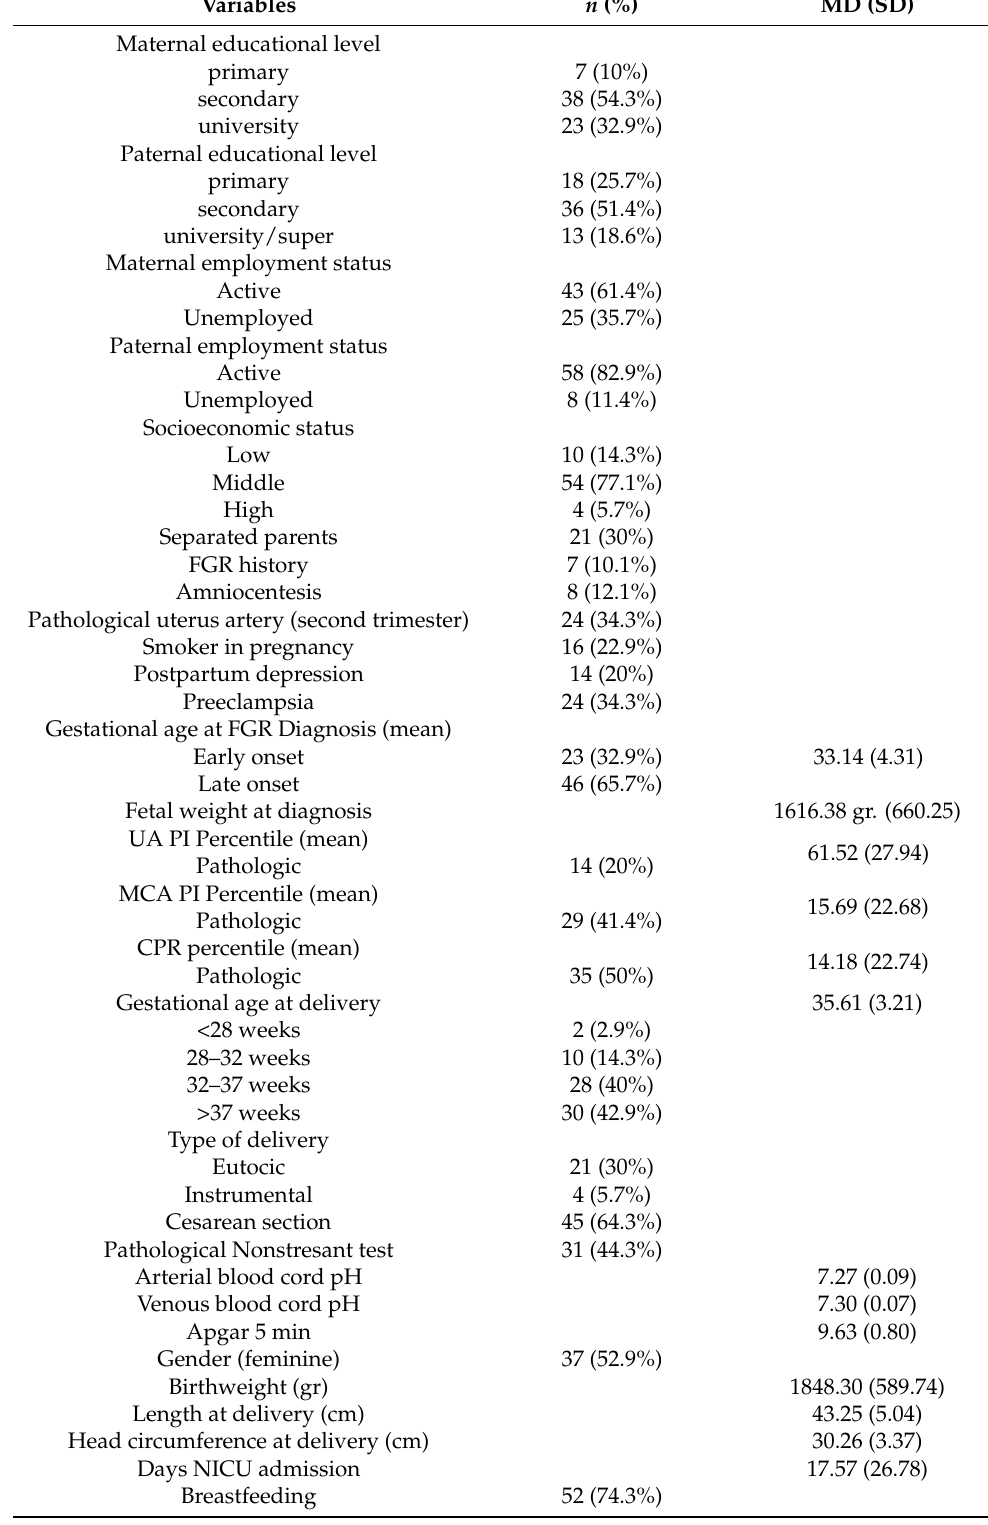
Table 1. Sociodemographic and delivery